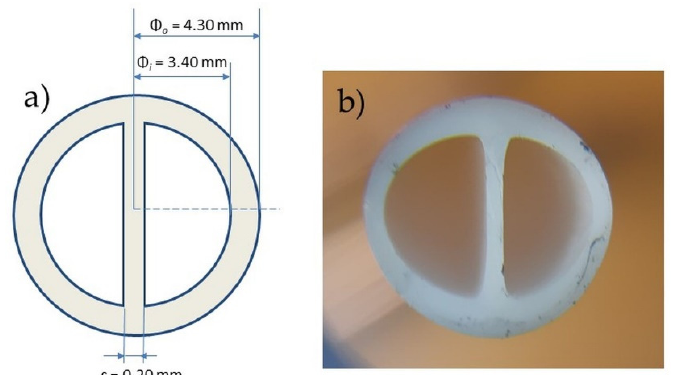
Figure 1. ( a ) Side view of the CVC with indication of the outer (Ø o ), inner (Ø i ) and septum ( s ) dimensions. ( b ) Magnificated picture of the CVC section.